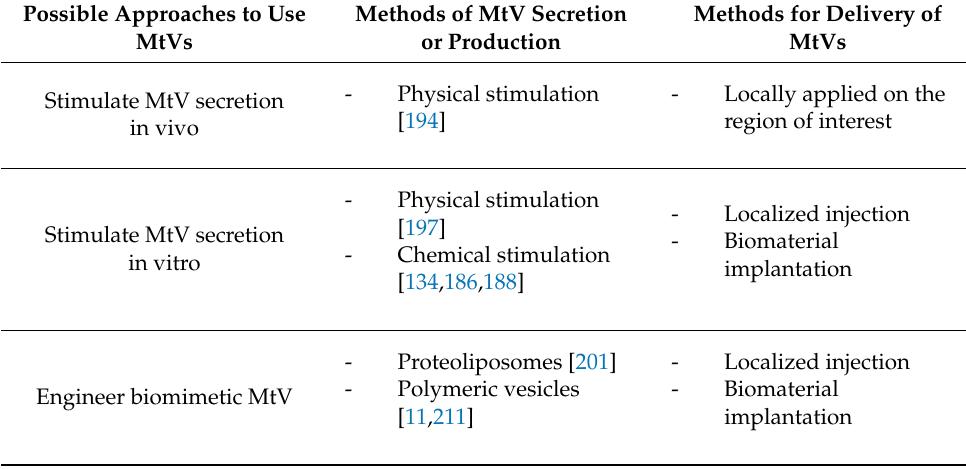
Table 3. Approaches for therapeutic uses of